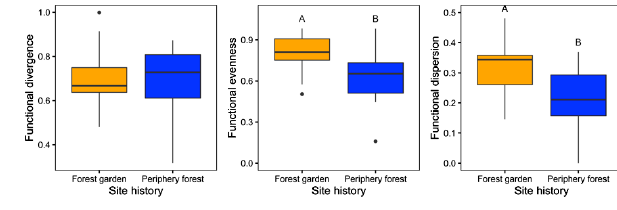
Fig. 5 . Functional Diversity Measures between Forest Gardens and Periphery Forests. Comparisons of functional diversity at forest gardens and peripheral forests, functional divergence did not show a significant response to site history (P =